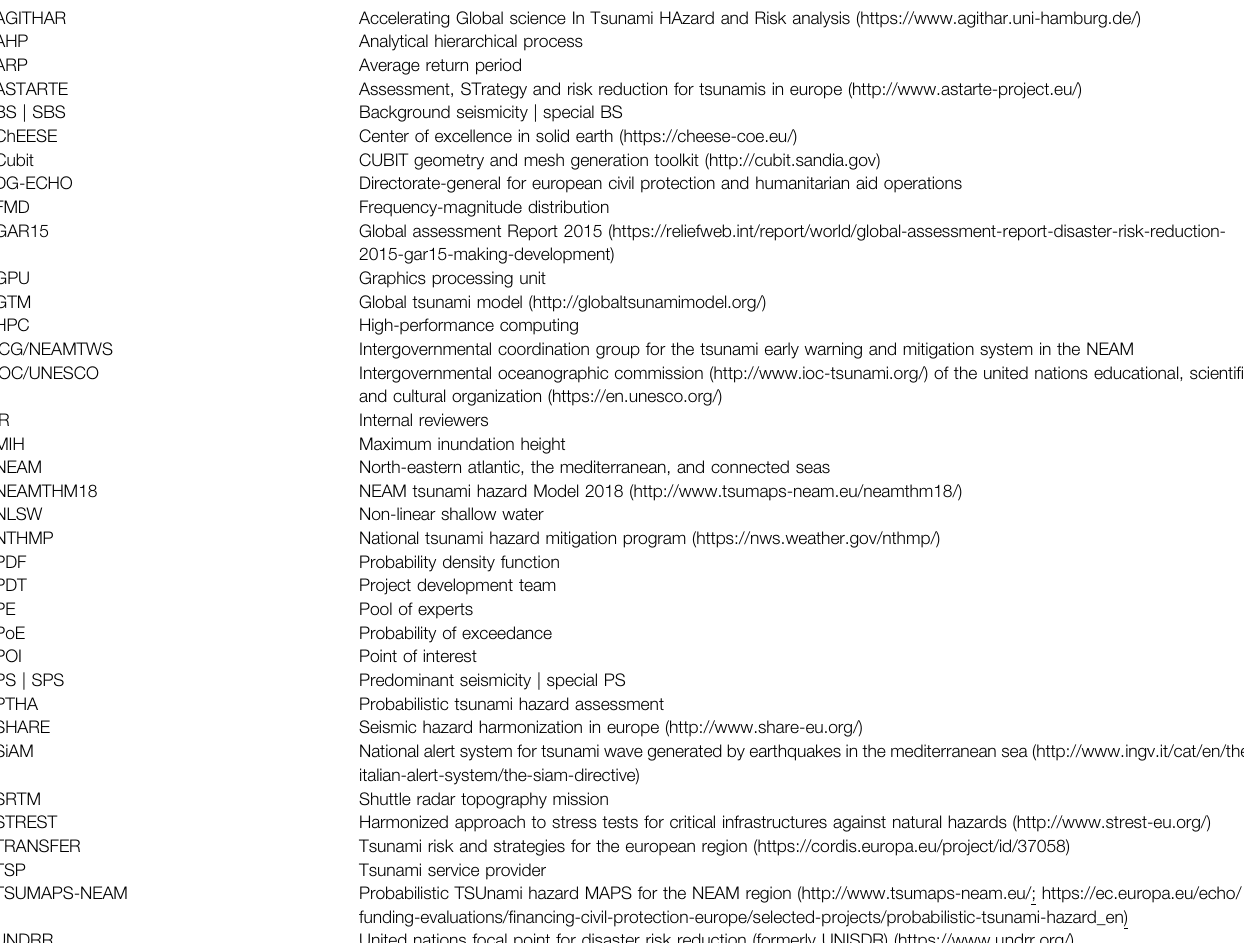
TABLE 1 | List of Acronyms, abbreviations, and relevant websites.